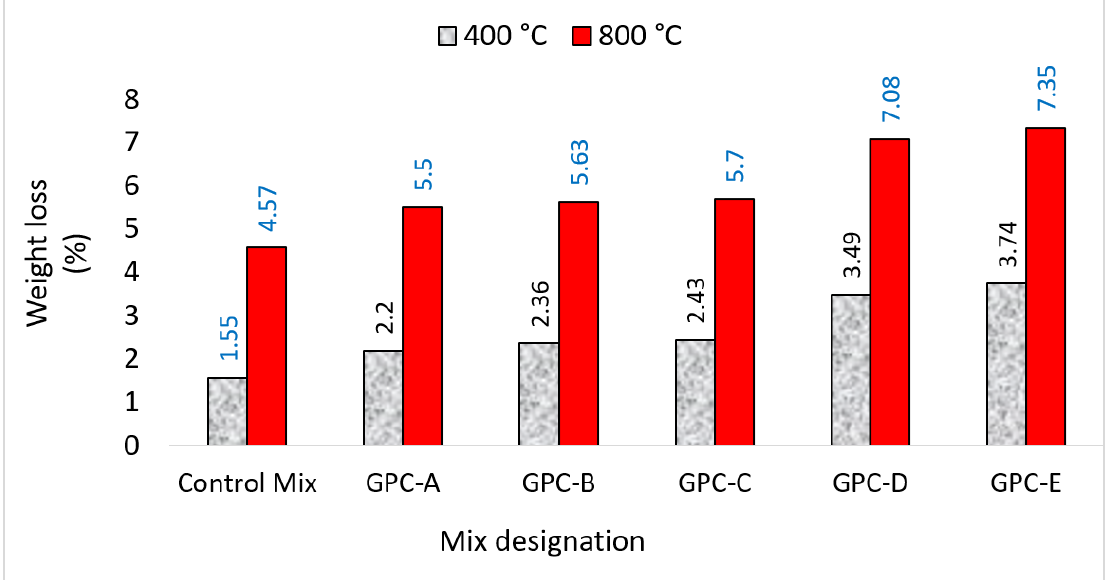
Figure 8. The weight loss in OPC and QFS-GPC specimens after exposure to 400 °C and 800 °C temperatures.